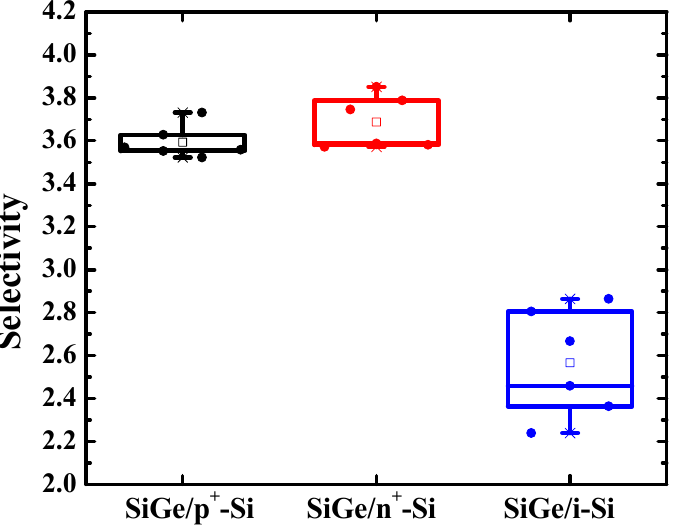
Figure 7. Box plot of the selectivity of SiGe/n + -Si, SiGe/p + -Si, and SiGe/i-Si. The means and the standard deviations are 3.59, 3.68, and 2.56 and 0.0759, 0.1228, and 0.2512, respectively. Significant improvements in the selectivity for doped Si were observed. The selectivity of SiGe/n + -Si and SiGe/p + -Si was similar, but the variation in SiGe/n + -Si was larger.